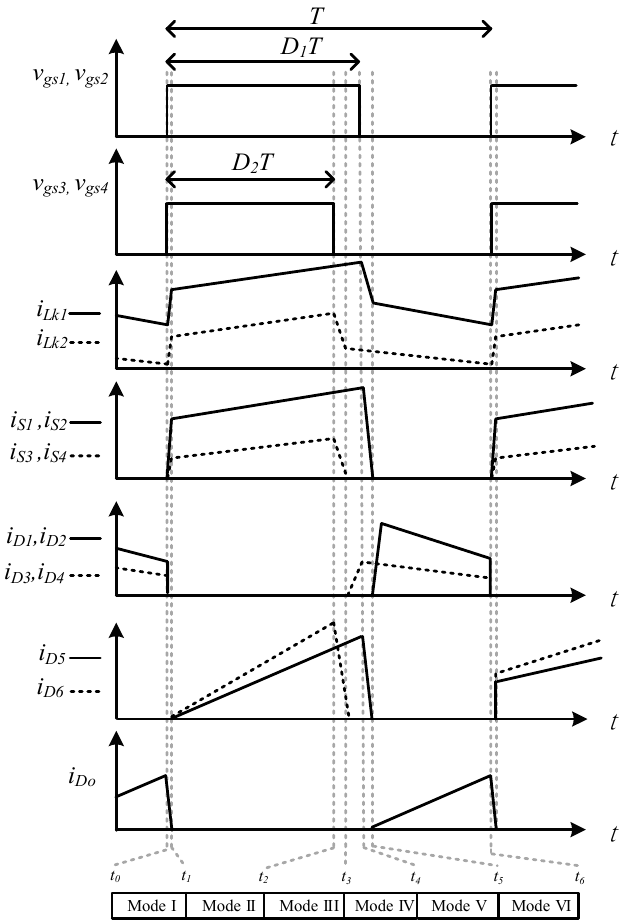
Figure 3. The conceptual key waveform of the proposed converter at DIO (dual input operation) and CCM (continuous conduction mode)